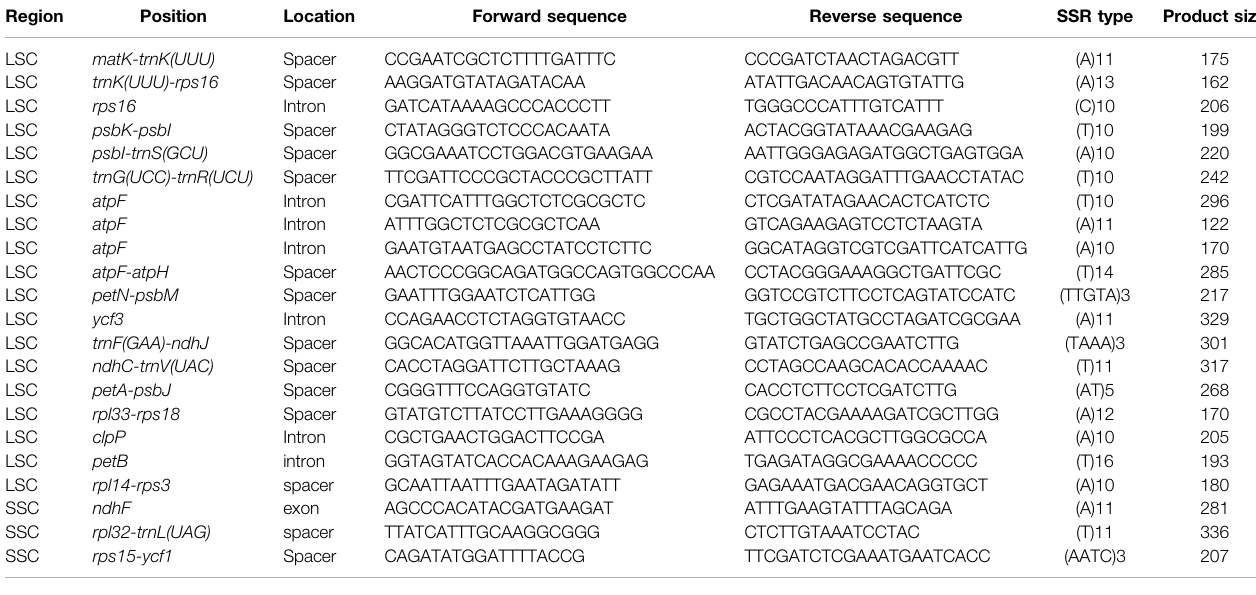
TABLE 5 | SSRs identi fi ed from in silico comparative analysis of the chloroplast genomes of eight haplotypes.